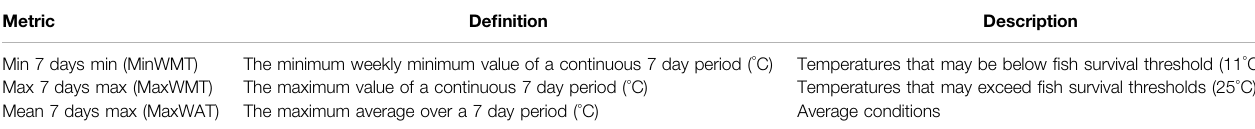
TABLE 1 | River temperature metrics used to evaluate the model results from different restoration scenarios in terms of fi sh thermal habitat suitability.